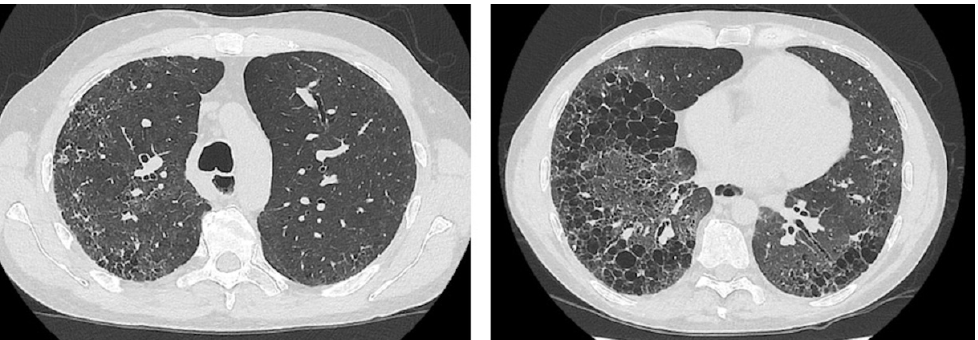
Figure 1. Axial High-Resolution Computed Tomography (HRCT) images showing a typical Usual Interstitial Pneumoniae (UIP) pattern that consists of predominantly basal and peripheral reticular opacities and honeycombing with traction bronchiectasis.